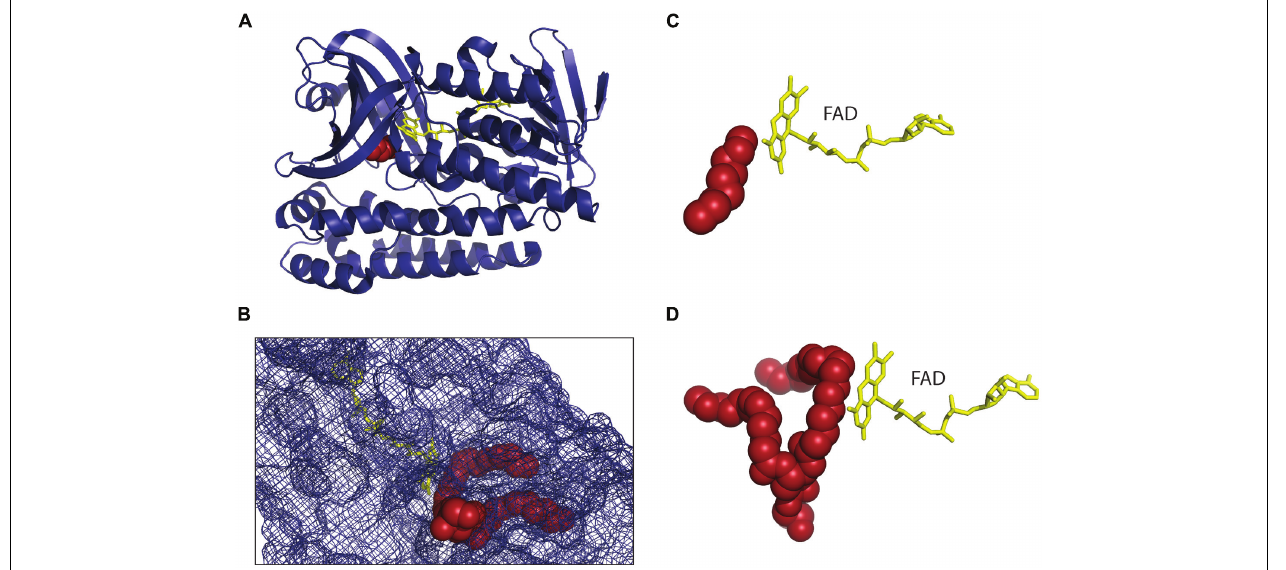
FIGURE 4 | Structure of geranylgeranyl reductase (GGR). (A) The crystal structure of Sulfolobus acidocaldarius GGR at 1.85 Å resolution (PDB: 3ATQ) is shown (Sasaki etal., 2011) in complex with FAD (yellow). It is similar to the structure of GGR from Thermoplasma acidophilum (PDB: 3OZ2; Xu etal., 2010) sharing the FAD binding and the catalytic domain. Both the enzymes were crystallized where a lipid molecule (red) originating from the host